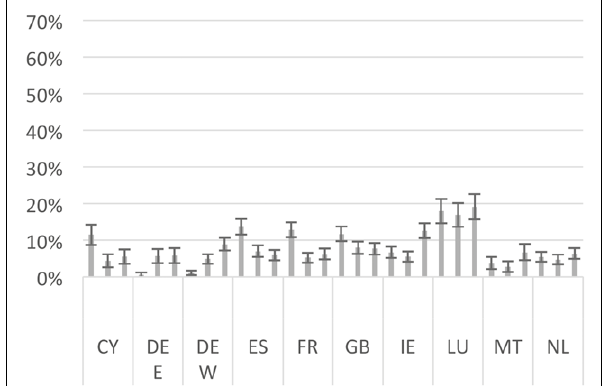
Figure 1a: The percentage of people saying housing is a countrywide problem (2008, 2013, 2018), selected countries Figure 1b: The percentage of people saying housing is a personal problem (2008, 2013, 2018), selected